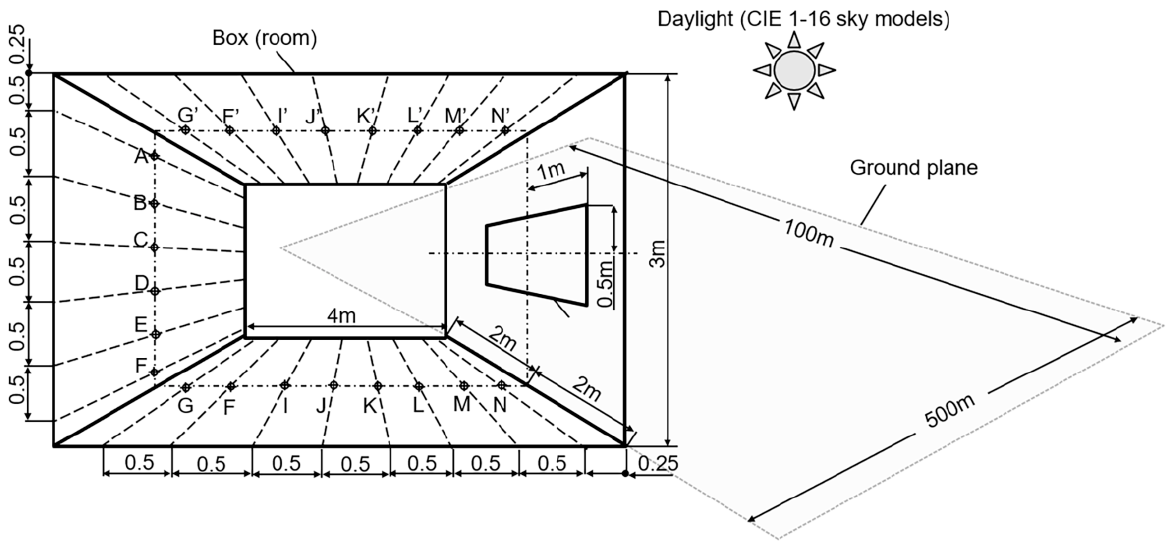
Figure 9. The scheme of scene for test 5.11 from CIE 171:2006.